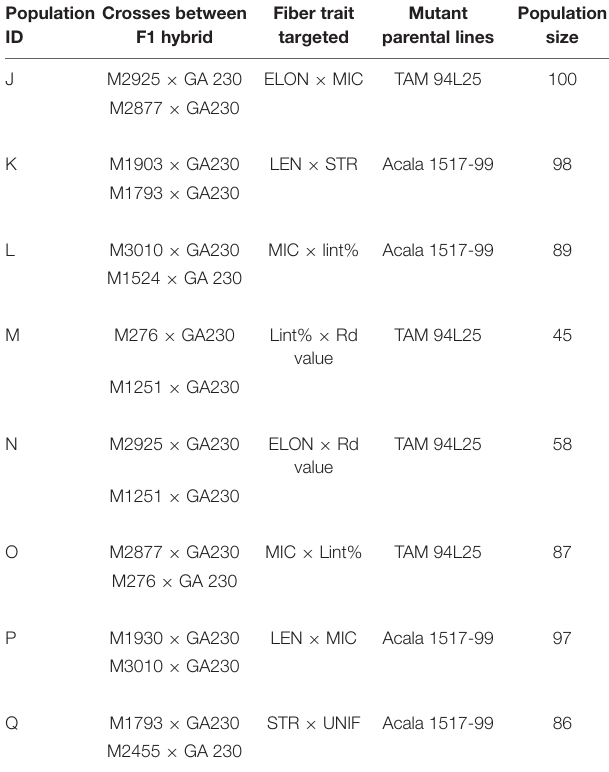
TABLE 2 | Crossing scheme between F1 hybrid for mutant